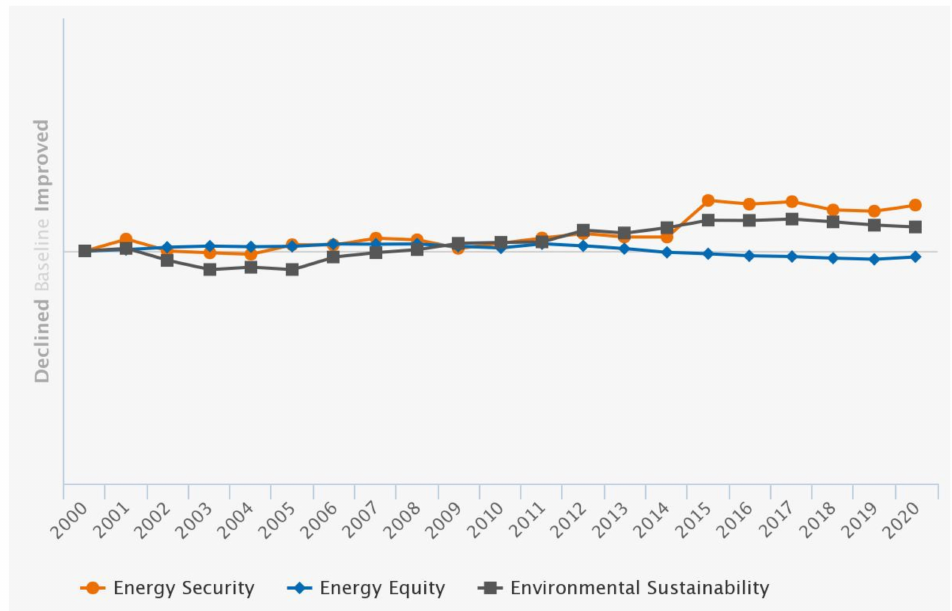
Figure 15. Trends of the components of the Energy Trilemma Index for Greece, 2000–2020 (based on